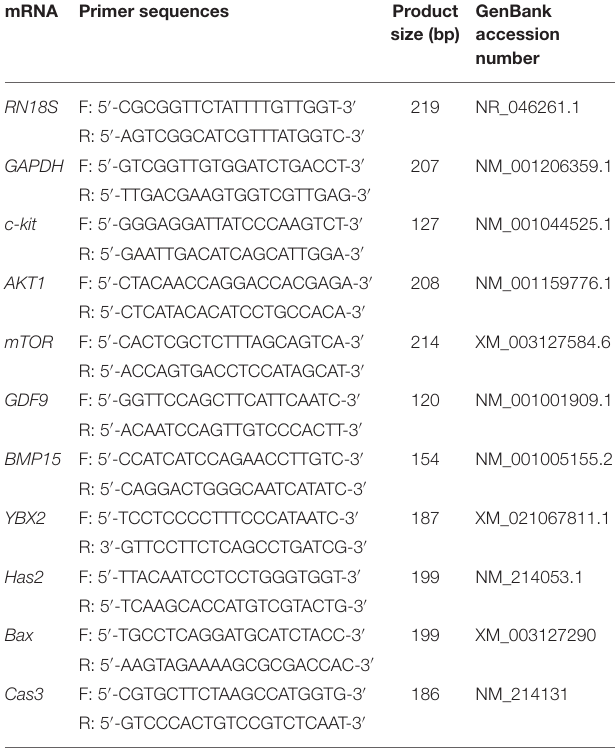
TABLE 1 | Primer sequences for